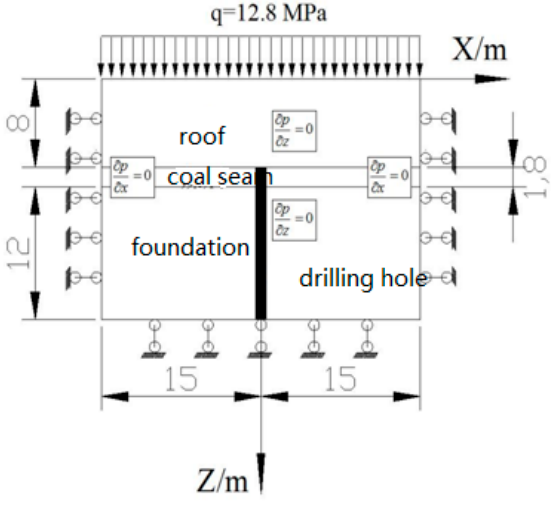
Figure 2. The numerical model.